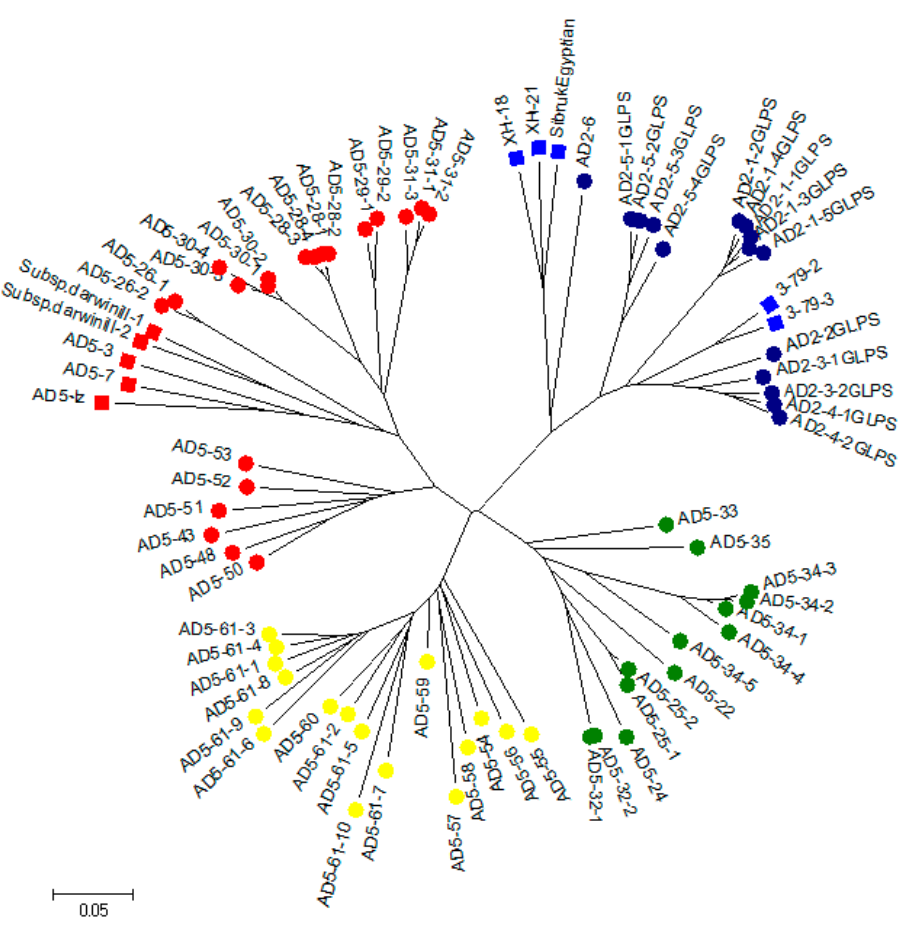
Figure 3. Dendrogram based on NJ analysis. The different colored dots indicate the wild-type accessions, while red and light blue squares represent the improved accessions.